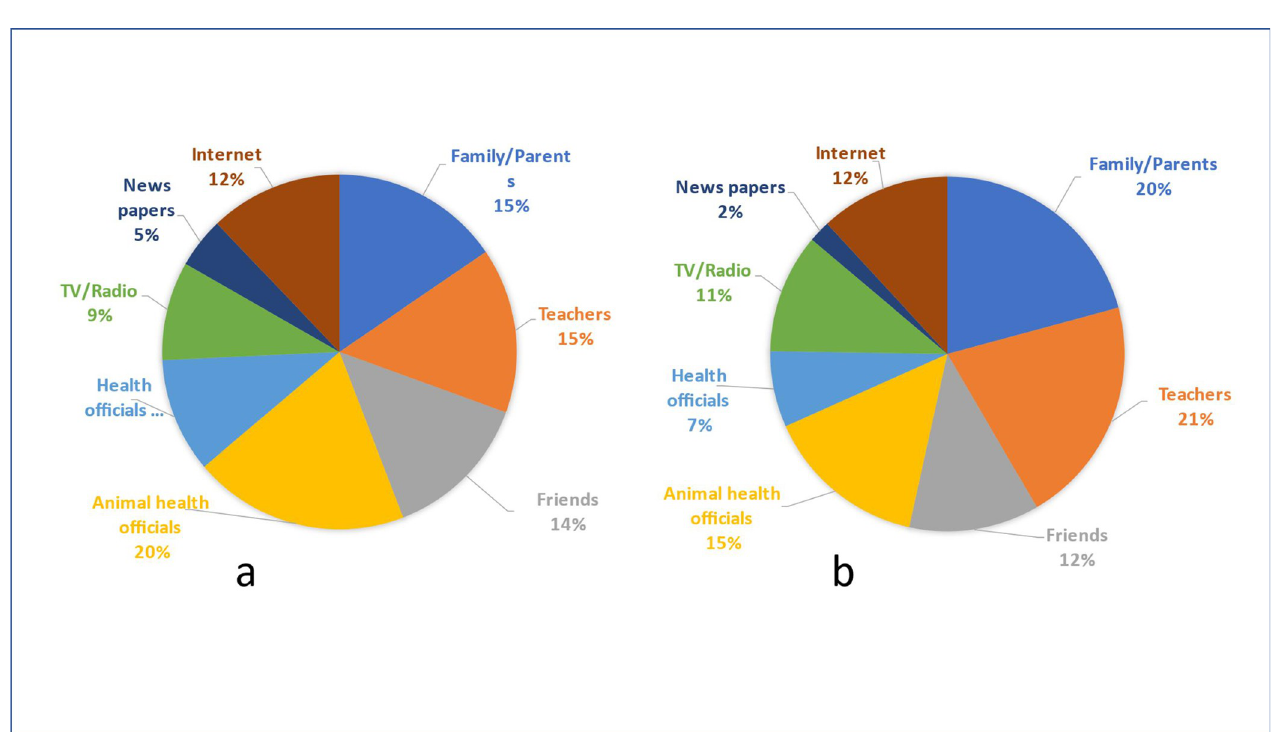
Fig 3. Source of information on rabies at day T0 (pre-test questionnaire survey) among students: a) Intervention group (n = 94), and b) Control group (n = 35).